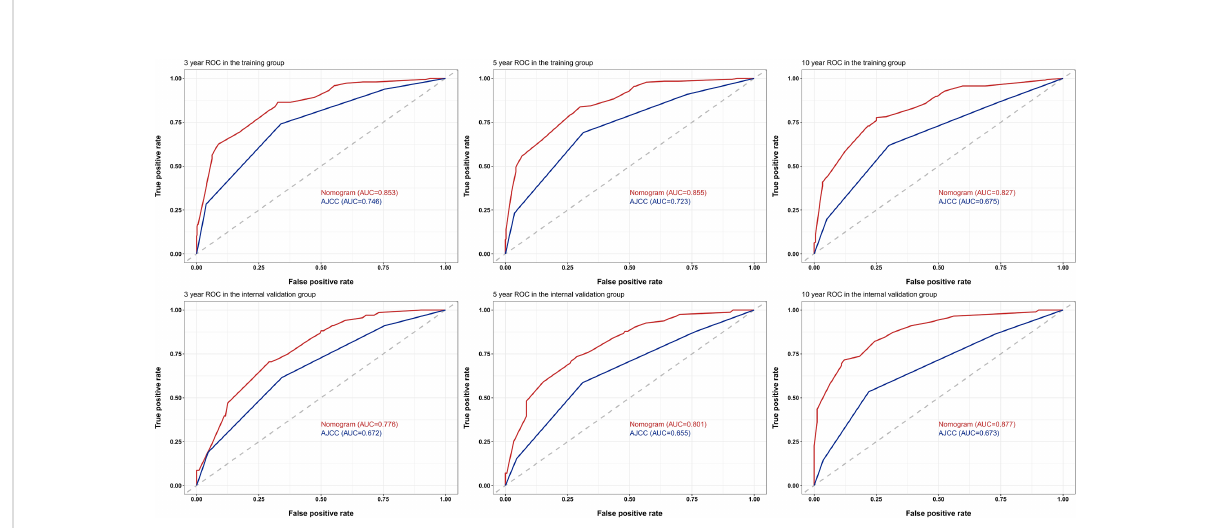
FIGURE 3 Receiver operating characteristic (ROC) curves for survival at 3, 5, and 10 years using the nomogram compared with AJCC8 data in the training and internal-validation groups. AUC, area under the curve; AJCC, American Joint Committee on